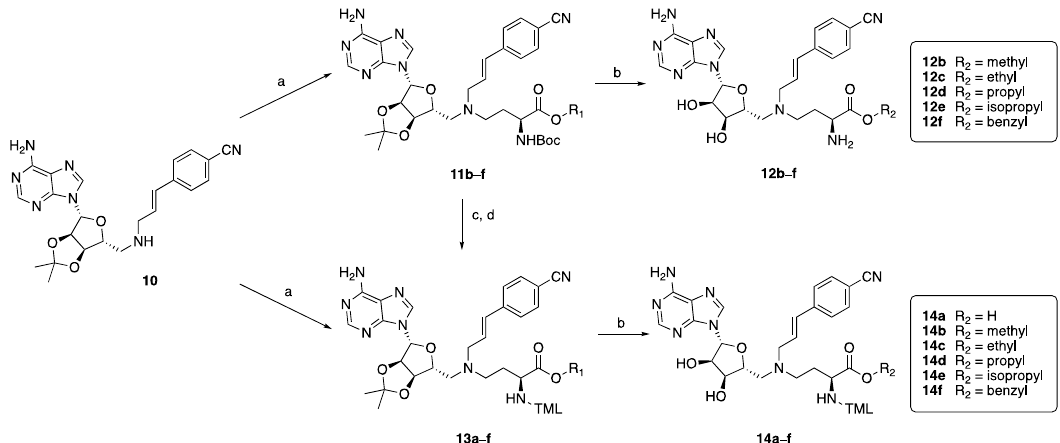
Scheme 2. Synthesis of prodrugs 12b – f and 14a – f . Reagents and conditions: ( a ) aldehydes 5b – f or 9a , NaBH(OAc) 3 , AcOH, DCE, rt, overnight (34–73%); ( b ) TFA, CH 2 Cl 2 , H 2 O, rt, 2 h (70–93%); ( c ) TFA, CH 2 Cl 2 , rt, 2 h; ( d ) TML acid 7, BOP, Et 3 N, CH2Cl 2 , rt, 2 h (77–83%). Table 1. Stability data of the prodrugs in Tris buffer at pH 8.4 and in PBS buffer at pH 7.4. The values indicate the percentage of compound peak area present after 16 h of incubation at room temperature.